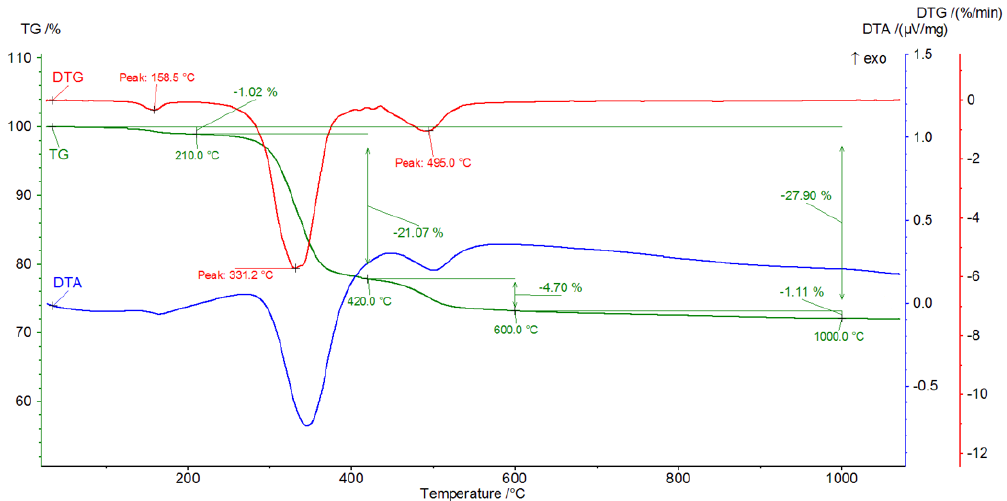
Figure 9. DTA/TG/DTG thermal curves of sample W as a function of temperature in the range 30 – 1000 °C.